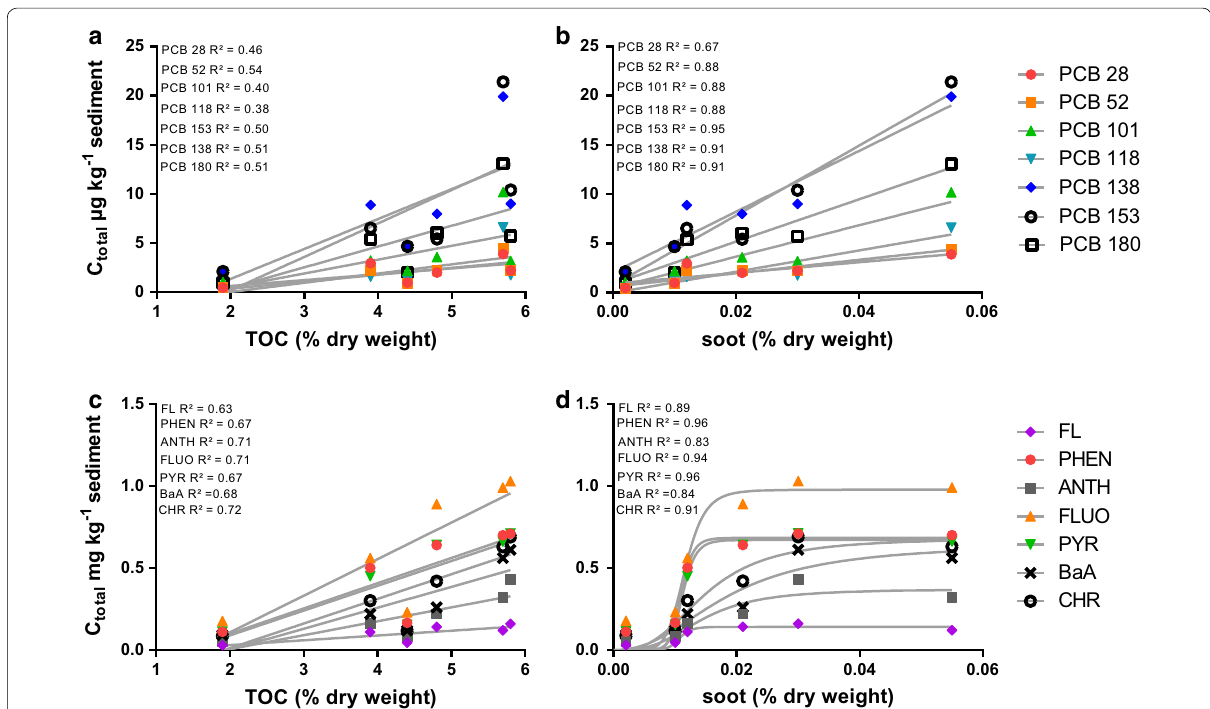
Fig. 5 Total concentrations ( C total , n 1) in Elbe sediments correlated with TOC or soot content for PCBs ( a , b ) and PAHs ( c , d ). R 2 values were = obtained with a linear regression for a , b and c and for d with a specific-binding with Hill-slope equation